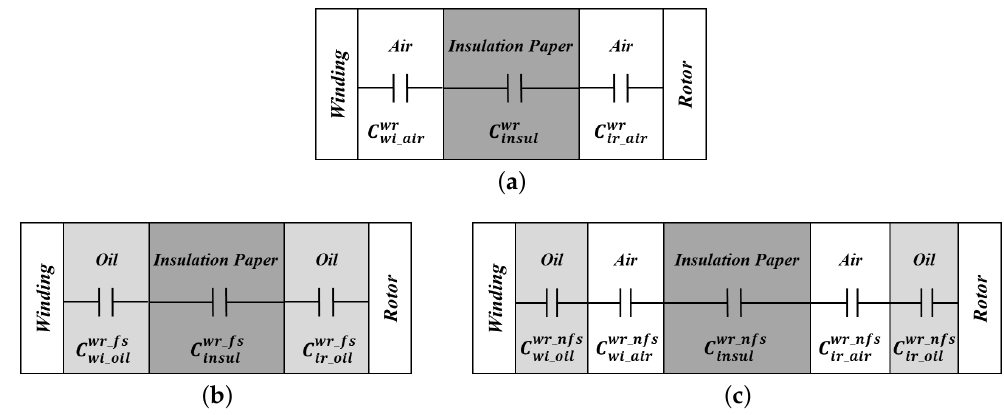
Figure 7. Winding-to-stator capacitance circuits: ( a ) without cooling oil, ( b ) oil-filled slot, and ( c ) oil-unfilled